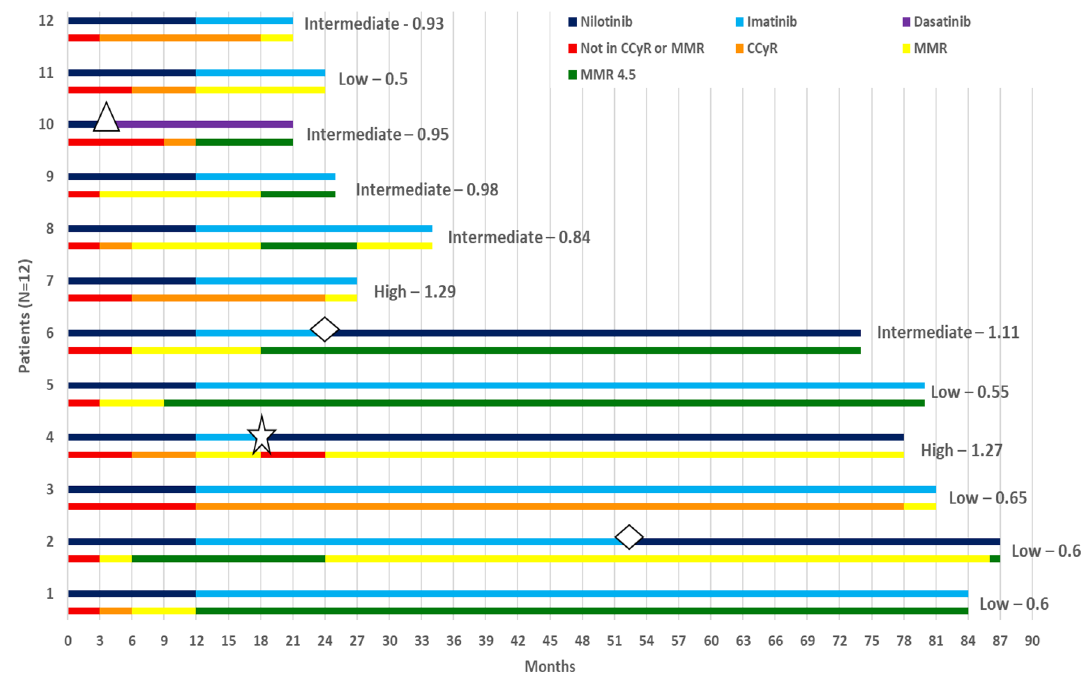
Fig. 1 The swimmers plot illustrates the duration of treatment with each tyrosine kinase inhibitor (Upper Bar) for 12 CML patients and marks the response milestones (Lower Bar). The sokal score is indi- cated at the end of the horizontal bar for each patient. Unfilled tri-